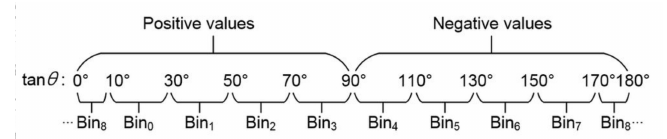
Figure 4. Dividing orientations into nine bins in the proposed scheme.